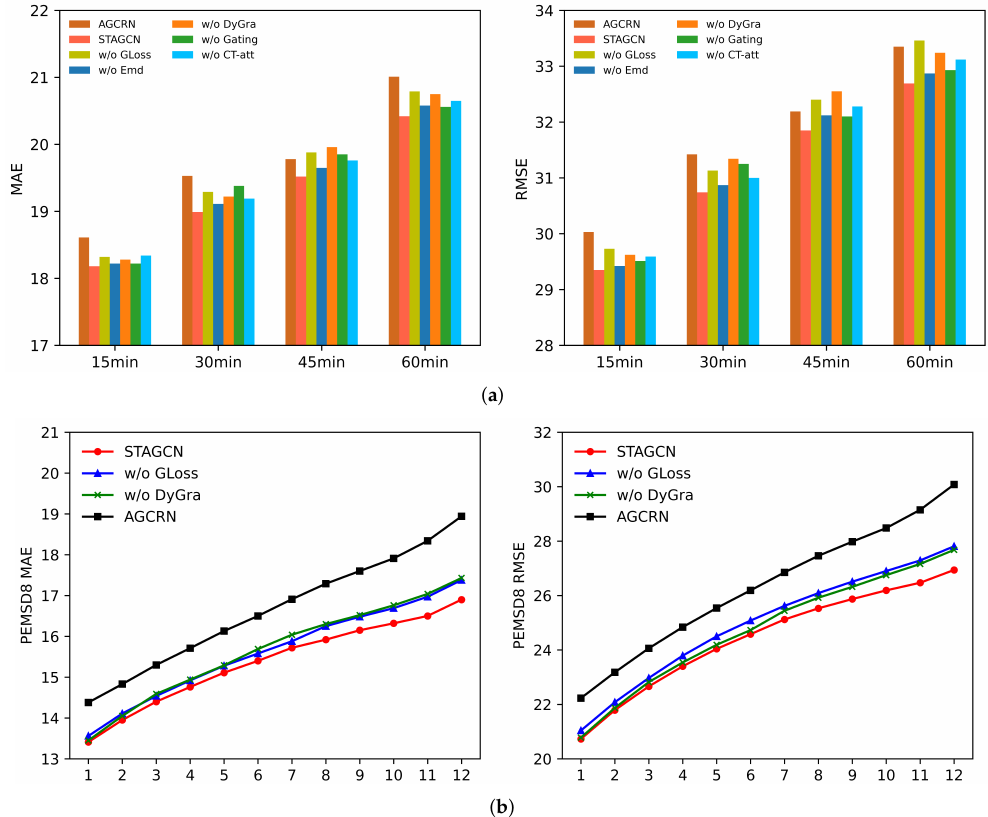
Figure 5. Component analysis of STAGCN on two datasets. ( a ) Ablation study on PEMSD4, ( b ) per- formance comparison at each prediction